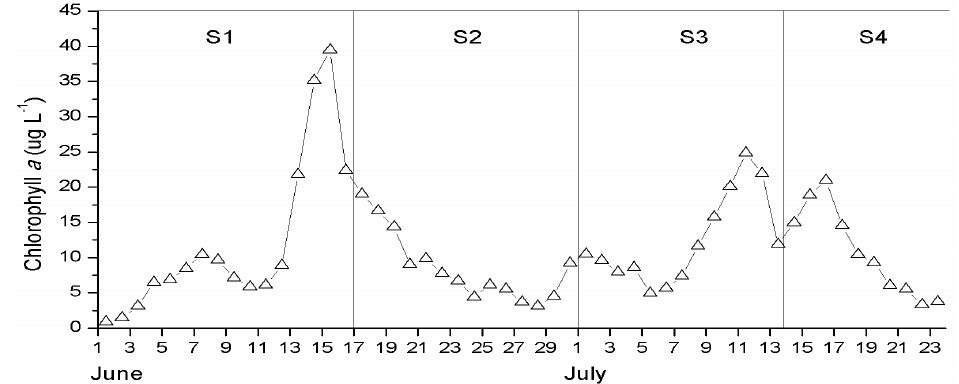
Figure 6. Variations in the daily average Chl a concentration in Xiangxi Bay from 1 June to 23 July 2008. S1–S4 were divided according to the value of TN / TP = 29. S1: TN / TP < 29, S2: TN / TP > 29; S3: TN / TP < 29; S4: TN / TP > 29.